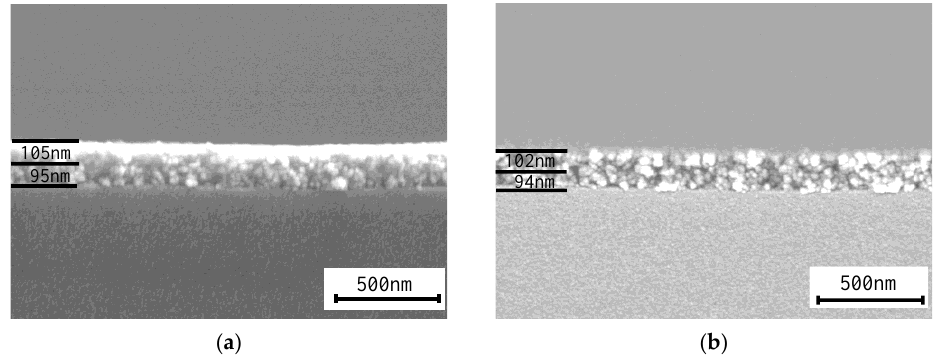
Figure 9. Cross-sectional SEM image of the untreated double-layer AR coating ( a ) and the film after treatment ( b ). treatment ( b ).